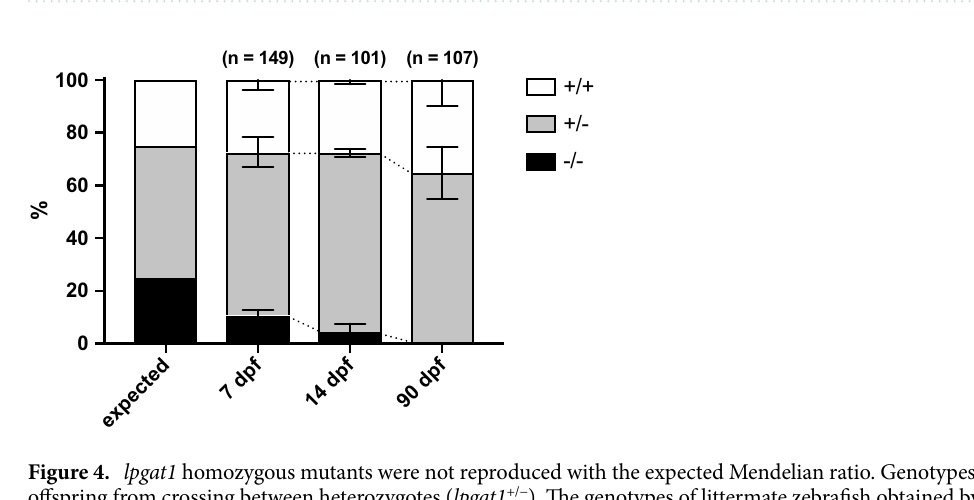
Figure 3. lpgat1 heterozygotes produce some sperm with less motility and abnormal morphology. ( A ) Percentage of sperm with motility from lpgat1 +/+ and lpgat1 +/ − . Semen was collected from anesthetized zebrafish by abdominal compression. Sperm motility was measured by Computer Assisted Semen Analysis, CASA. Each point represents the results of different individual zebrafish (n = 12 for both lpgat1 +/+ and lpgat1 +/ − , The data were combined from mutant 1 (n = 7) and 2 (n = 5)). Error bars are S.D. Statistically significant differences are marked with asterisks. * p < 0.05; ** p < 0.01. Unpaired, two-tailed t -test was used. ( B ) Schematic diagram of zebrafish sperm. Zebrafish sperm consists of a head, a mid-piece, and a tail. Unlike sperm from mammals, sperm from zebrafish have no acrosome. The head contains the nucleus, and the midpiece is enriched in mitochondria. ( C ) SEM analyses of sperm from lpgat1 +/+ and lpgat1 +/ − zebrafish. Representative images from mutant 1 were shown. Note that sperm from lpgat1 +/ − showed abnormal morphology with loose mid-piece indicated by red arrows. Scale bar, 1 µm. ( D ) Percentage of sperm with abnormal morphology in SEM analyses ( C ). Sperm from lpgat1 +/+ ; n = 52, from lpgat1 +/ − (mutant 1); n = 105.